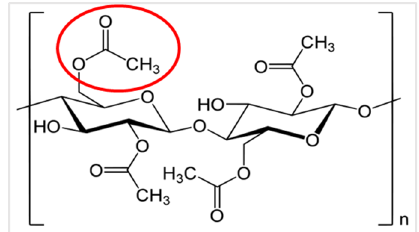
Figure 3. Polymer structure of cellulose acetate. One of the cellulose acetate groups is marked with a red circle.